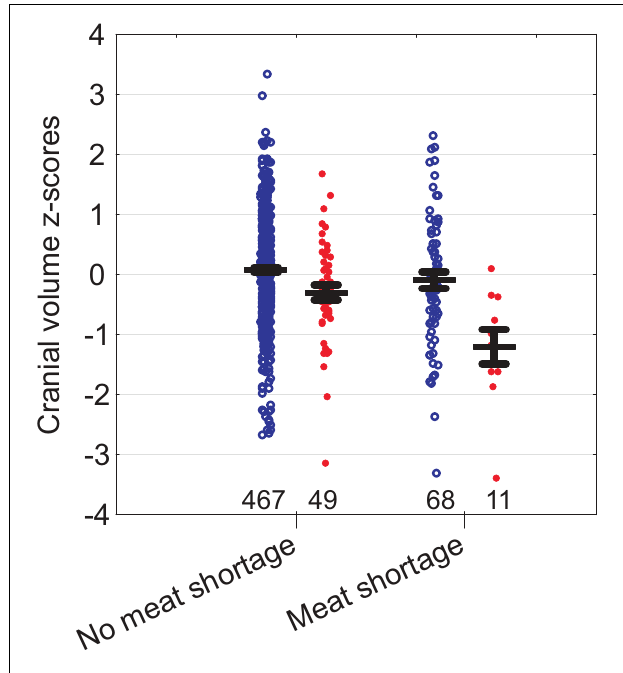
FIGURE 3 | Cranial volume of children in relation to self-reported meat shortage and paternal education (red filled symbols—primary education, blue open symbols—education above primary). Whiskers denote standard errors. Sample sizes at